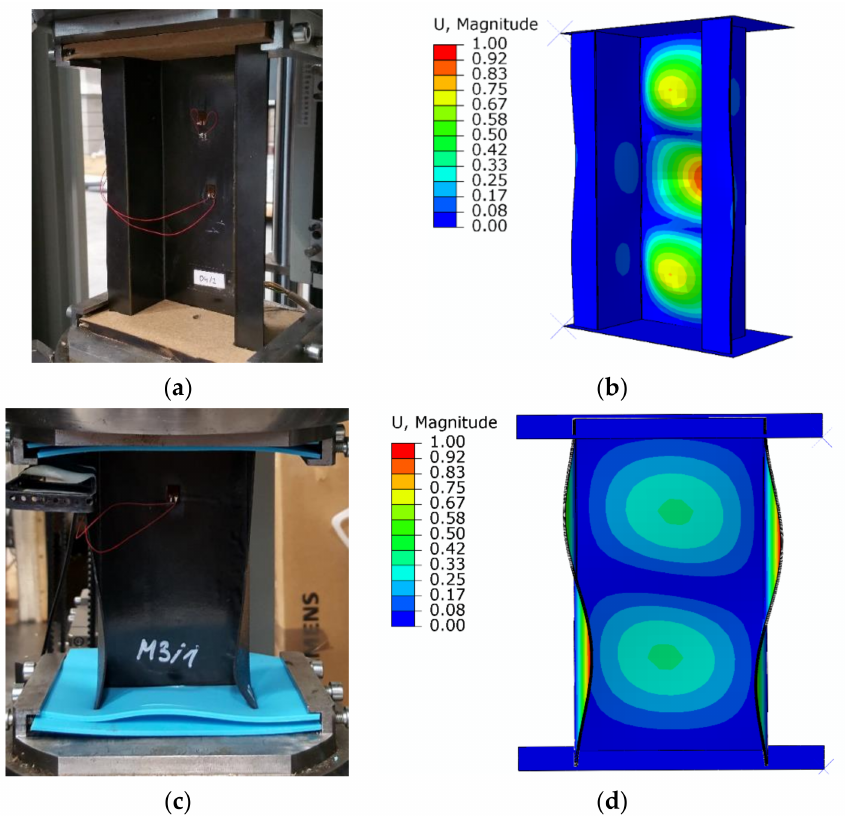
Figure 5. Buckling: ( a ) top-hat experimental study (EXP); ( b ) top-hat finite element method (FEM); ( c ) channel EXP; ( d ) channel FEM.